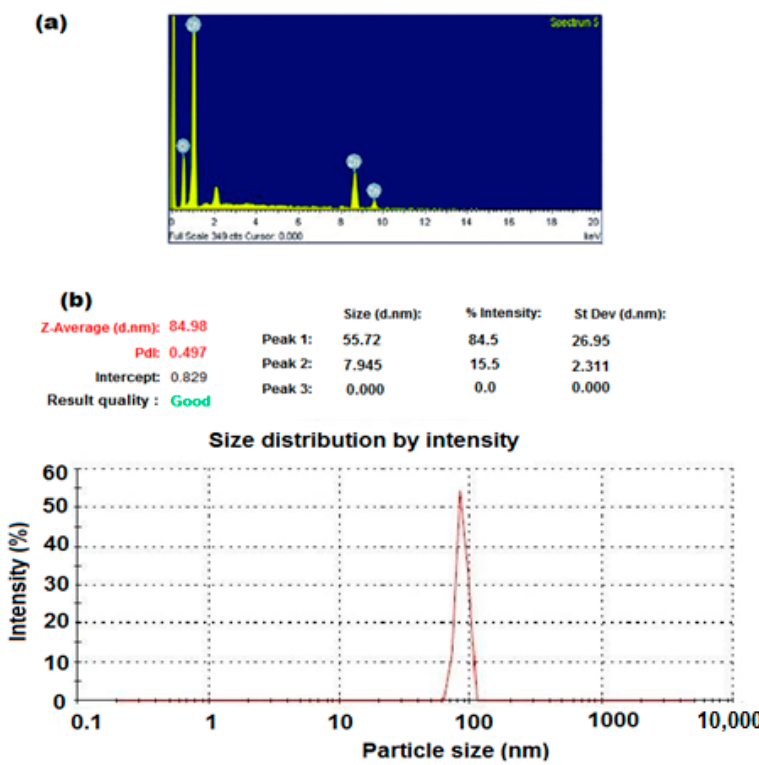
Figure 6. ( a ) Energy-Dispersive X-Ray Spectroscopy (EDX) of ZnONPs and ( b ) Particle size analyzer for ZnONPs using sol–gel method and zinc acetate as